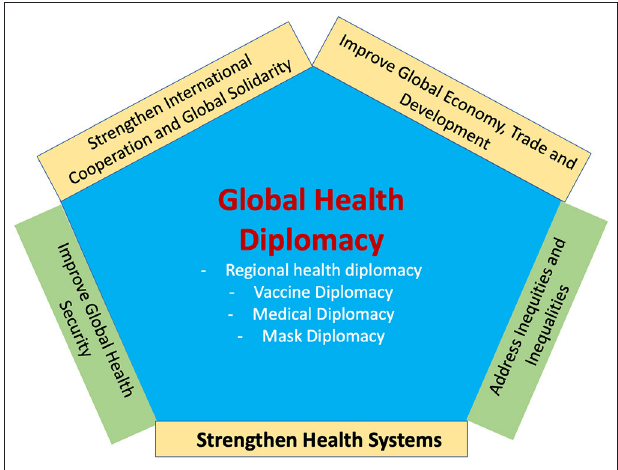
FIGURE 2 | Global health diplomacy and the five key areas of